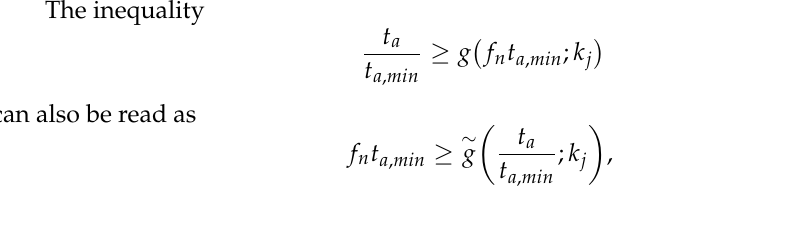
Figure 24. Curves showing the minimum value of t a / t a , min versus f n t a , min when t j is equal to k j / f n . The minimum value of t a depends on the natural frequency f n . The curves are monotonously decreasing. The analysis of what happens if f n changes for a given t a , min shows that if f n is high enough, a smaller value of t a / t a , min , i.e., a shorter acceleration time, can be adopted. On the contrary, for low values of f n , the acceleration time must be high .. ϑ Max cannot be enough and the acceleration limit